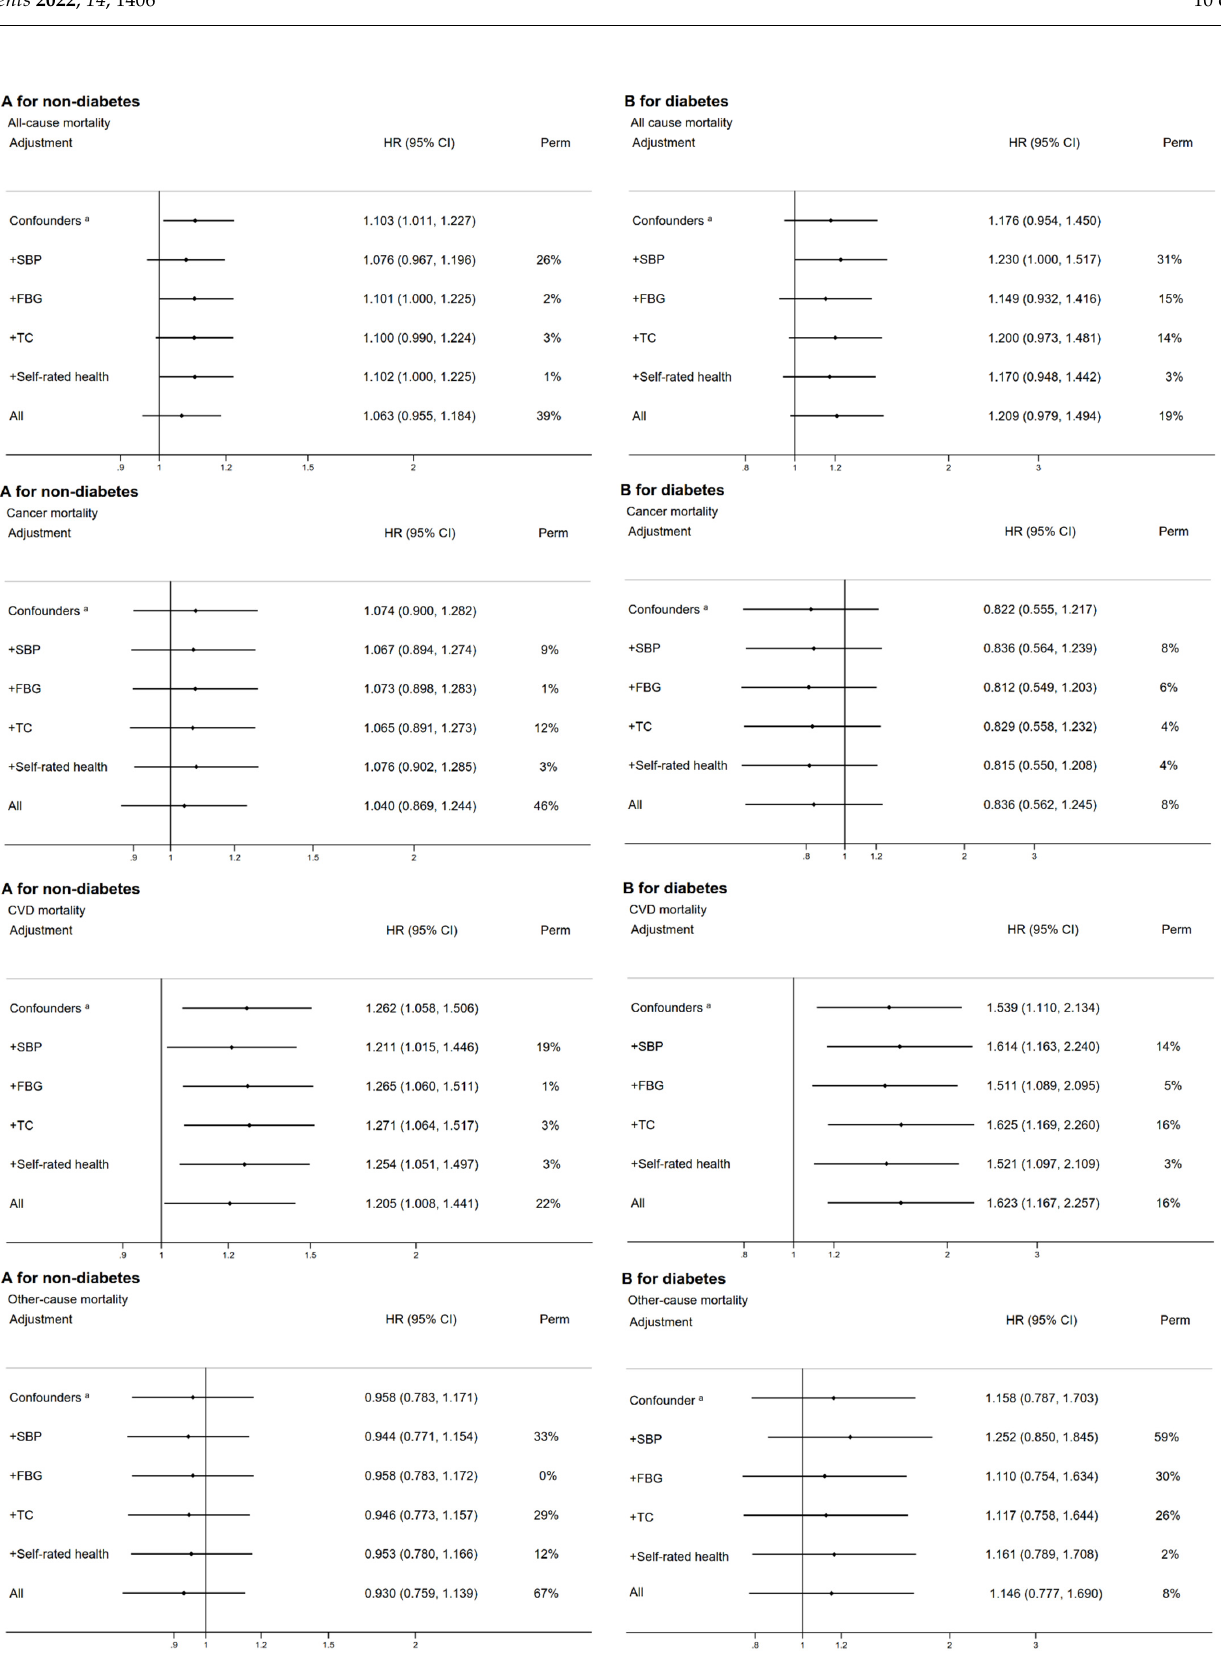
Figure 2. The associations between the vegetable-based LCD score (Q4 versus Q1) and mortality, and the proportions of the associations attributable to systolic blood pressure, fasting plasma-glucose, total cholesterol, and self-rated health ( A : participants without diabetes, B : participants with diabetes).